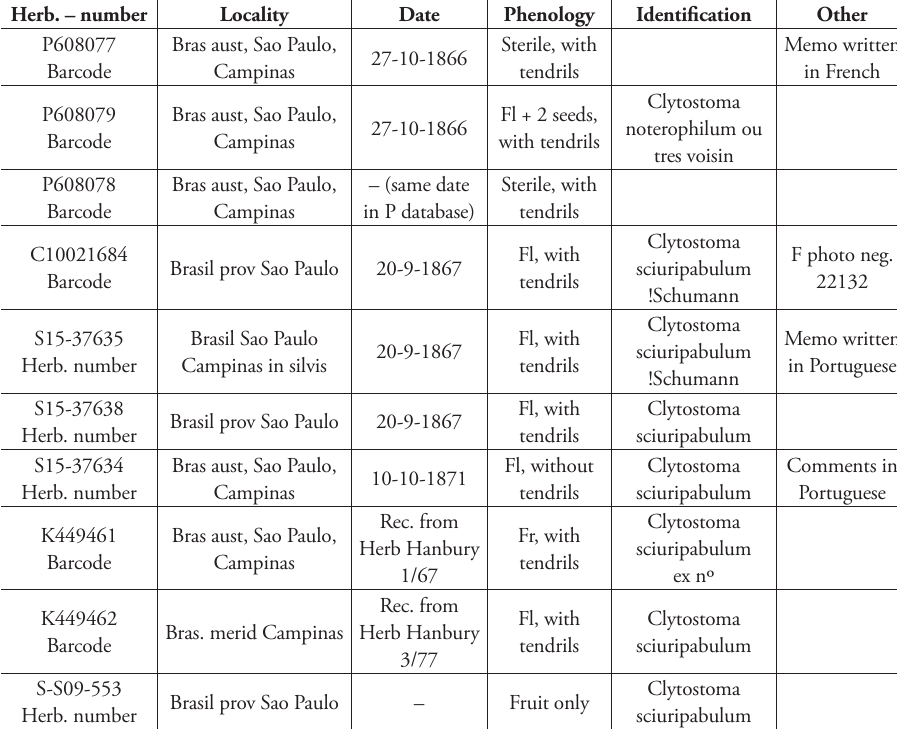
Table 1. Clytostoma sciuripabulum - Mello 22, list of syntypes. Herb. –